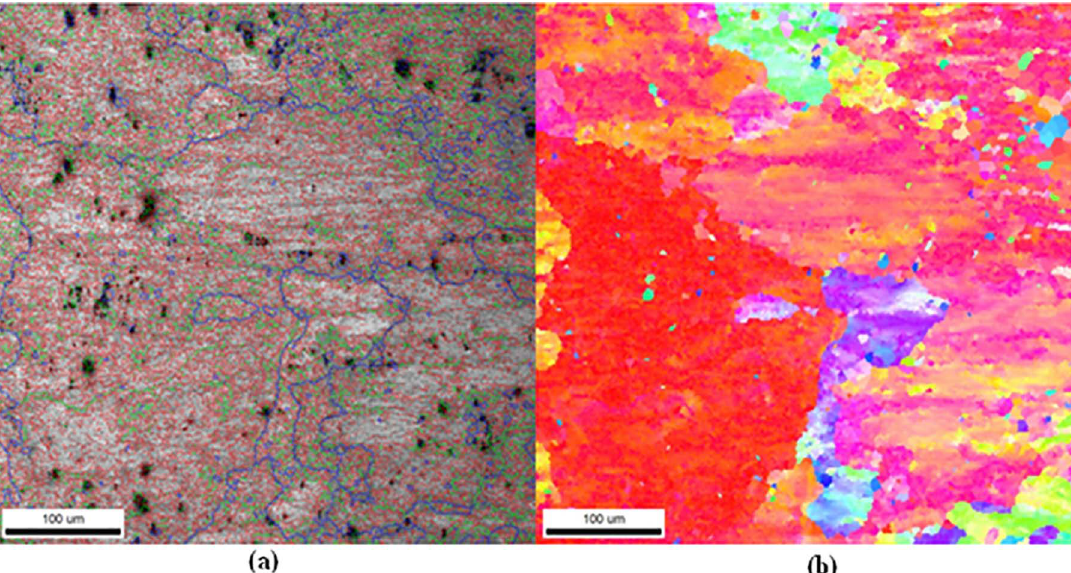
Figure 9. EBSD results for sample treated at 250°C for 4 hours. (a) Grain boundaries map. The red lines represent low-angle grain boundaries (θ < 5°), whilst green and blue lines represent medium (5° < θ < 15°) and high (θ > 15°) angle grain boundaries, respectively). (b) EBSD map showing only few new recrystallized